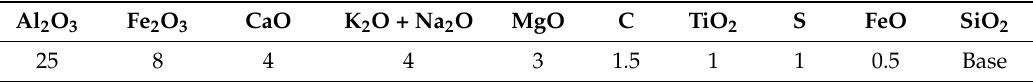
Table 2. Homemade “Typhoon ‐ Z” modifier chemical composition (wt %).